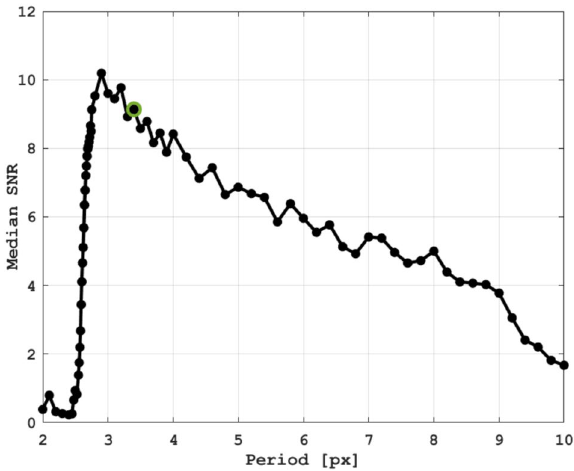
Figure 5. Modelled signal-to-noise ratio as function of modulation period. Each data point is a modelled median signal-to-noise ratio for a specified modulation period. The model is described in the Supplementary information. The highlighted data point (green circle) corresponds to the modulation period of the experimental data. The analysis shows that the measurement sensitivity is poor at low- and high modulation frequencies (near the Nyquist limit) and that a periodicity of 3 pixels yields highest